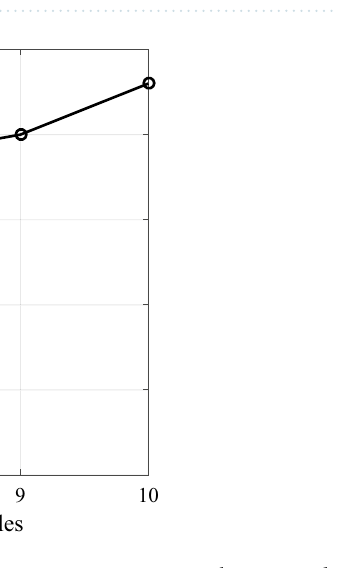
Figure 9. Visualization of EM-based Monte Carlo analysis for Circuit III: ( a ) at the nominal design, and ( b ) at the optimal design rendered with the use of the procedure introduced in this work. MC is executed using 500 random data points. Gray curves represent EM simulations, whereas the circuit characteristics at the nominal ( a ) and optimal design ( b ) are shown black.